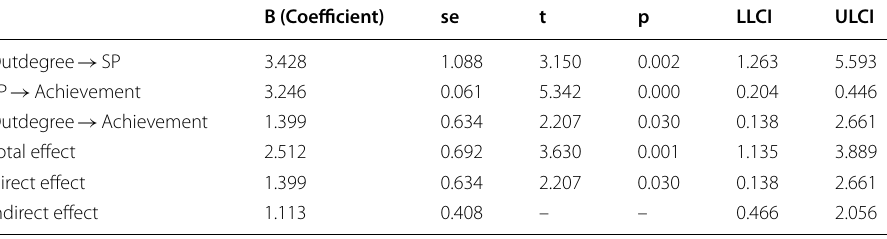
Table 6 The mediating effect of social presence on the relationship between outdegree and perceived learning achievement